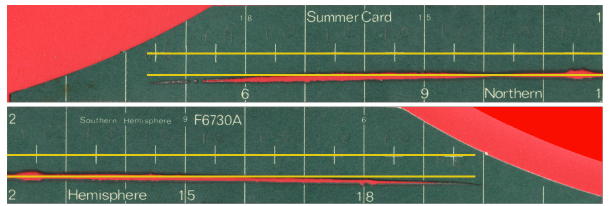
Fig. 4. Illustration of the rectification and registration method using a card from 17 July 2003. The straight yellow lines in the figure are parallel with the longer image edge. One line passes through the “+” markers on the card which are on the centre-line of the card. The other line is placed to show the deviation from linearity of the burn track described in the text. The image has been split to better fit the page.